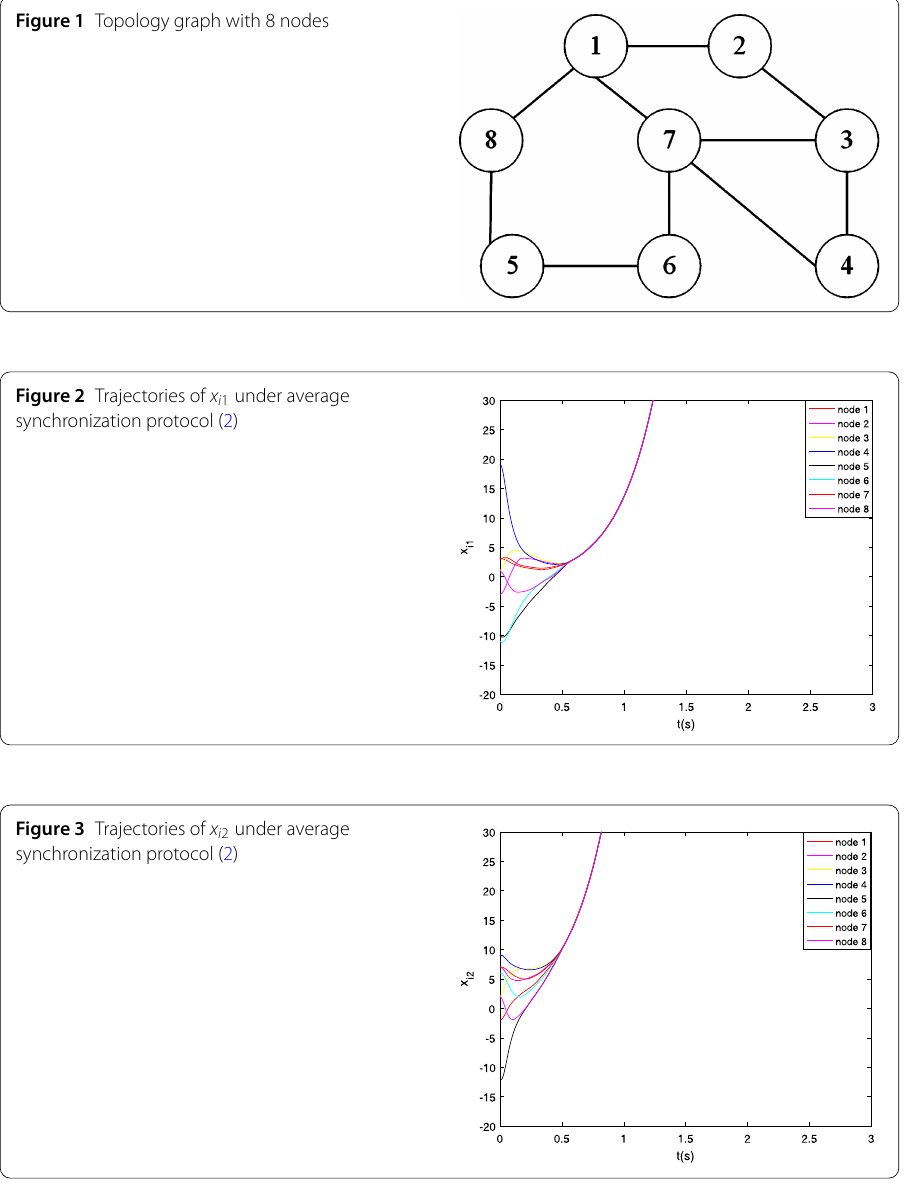
Figure 1 Topology graph with 8 nodes